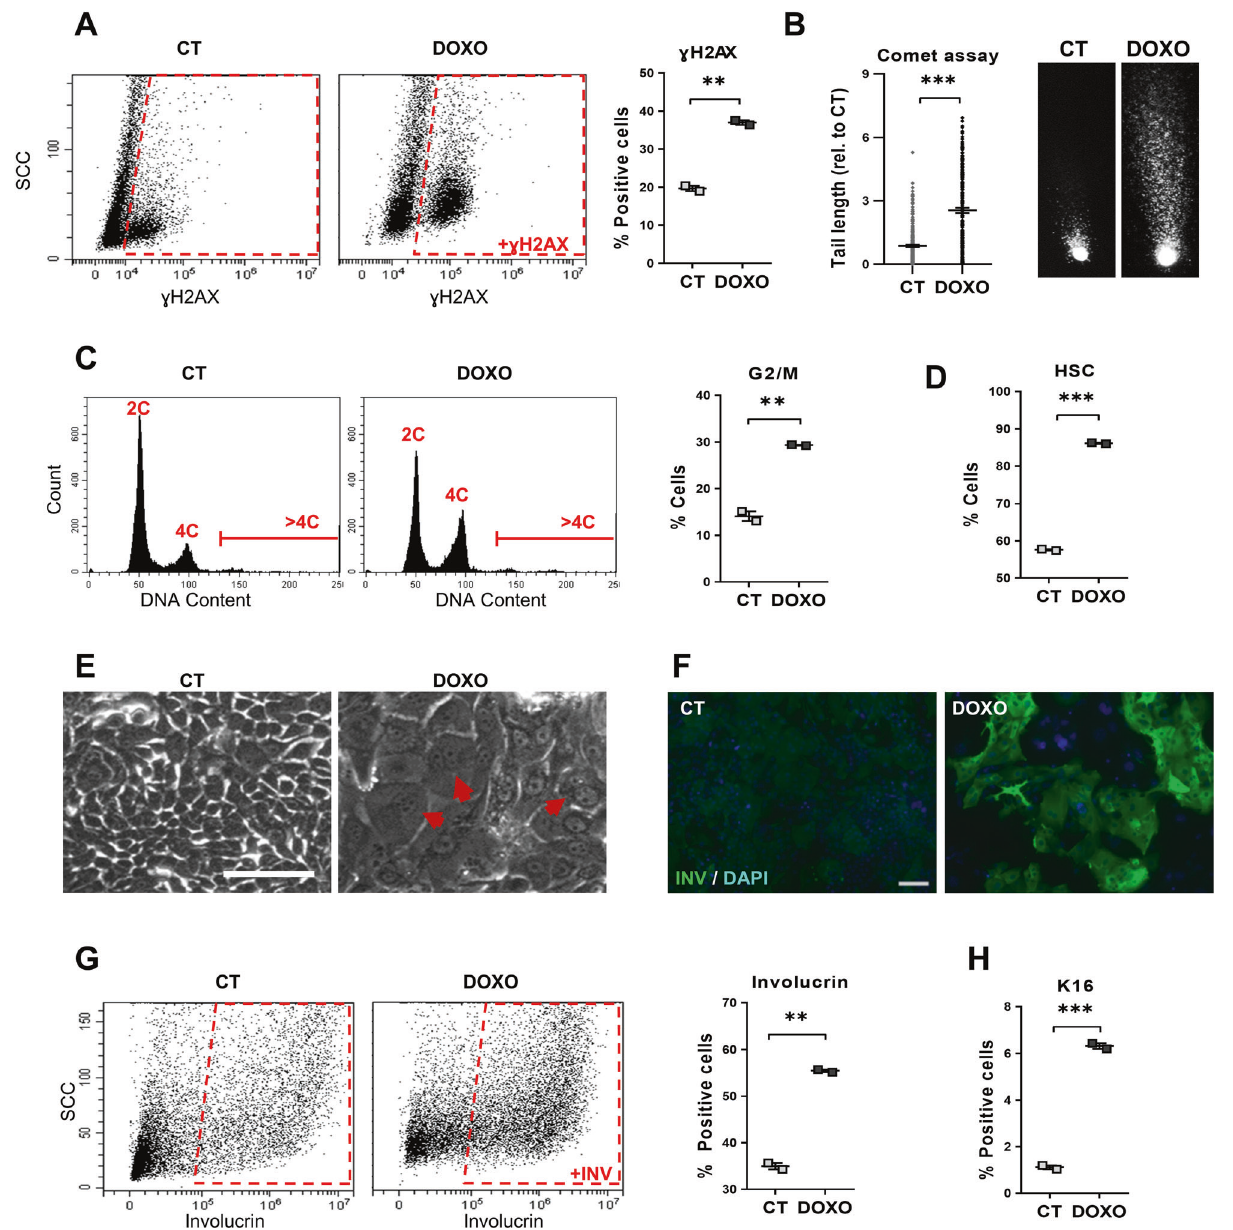
Fig. 1 Doxorubicin induces squamous metaplasia in human lung epithelial cells. Human primary lung epithelial cells were treated with the dimethyl sulfoxide vehicle (CT) or with 0.5 μ M Doxorubicin (DOXO) for 24 h ( A , C ) or 48 h ( B , D – H ). A Representative fl ow-cytometry analysis for the DNA damage marker γ H2AX ( + γ H2AX, positive cells). Quantitation in the right histogram. B DNA fragmentation as analysed by comet assays, measured by tail length relative to CT ( n = 245 – 247). Photographs show representative images of nuclei in CT or DOXO-treated cells as indicated. C Representative fl ow-cytometry analyses of DNA content of cells (2C, 4C, and >4C indicate diploid, mitotic/tetraploid and polyploid cells, respectively). Plot on the right shows percent of CT or DOXO cells in the G2/M phase of the cell cycle. D Percent of CT or DOXO-treated cells with high light scatter (HSC) typical of squamous differentiation, as analysed by fl ow cytometry. E Representative phase contrast images of cells treated for 48 h as indicated. Red arrows point at polyploid cells with several or large nuclei. Scale bar, 50 μ m. F Immuno fl uorescence for the squamous differentiation marker involucrin (green). Blue is nuclear DNA by DAPI. Scale bar, 100 μ m. G Representative fl ow cytometry analysis for involucrin ( + INV, positive cells). The percent of involucrin positive CT or DOXO-treated cells is shown on the right. H Percent of squamous marker keratin K16 positive cells, as analysed by fl ow cytometry. Flow cytometry analysis gates were stablished according to negative isotype antibody control. Data are mean ± SEM of duplicate samples, representative of 2 – 3 independent experiment from two different human individuals with similar results. *** p ≤ 0.001, ** p ≤